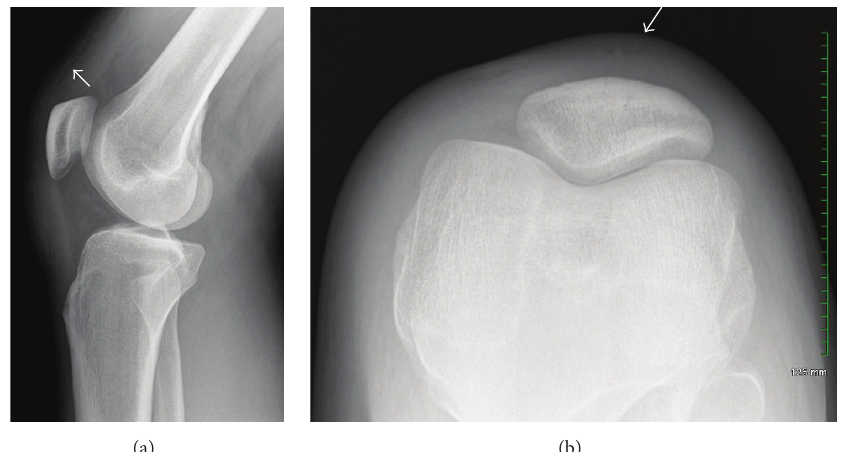
Figure 1: Plain radiography of the right knee. Lateral (a) and sunrise (b) views revealed anterior soft tissue swelling particularly in the superomedial patellar region (arrows).